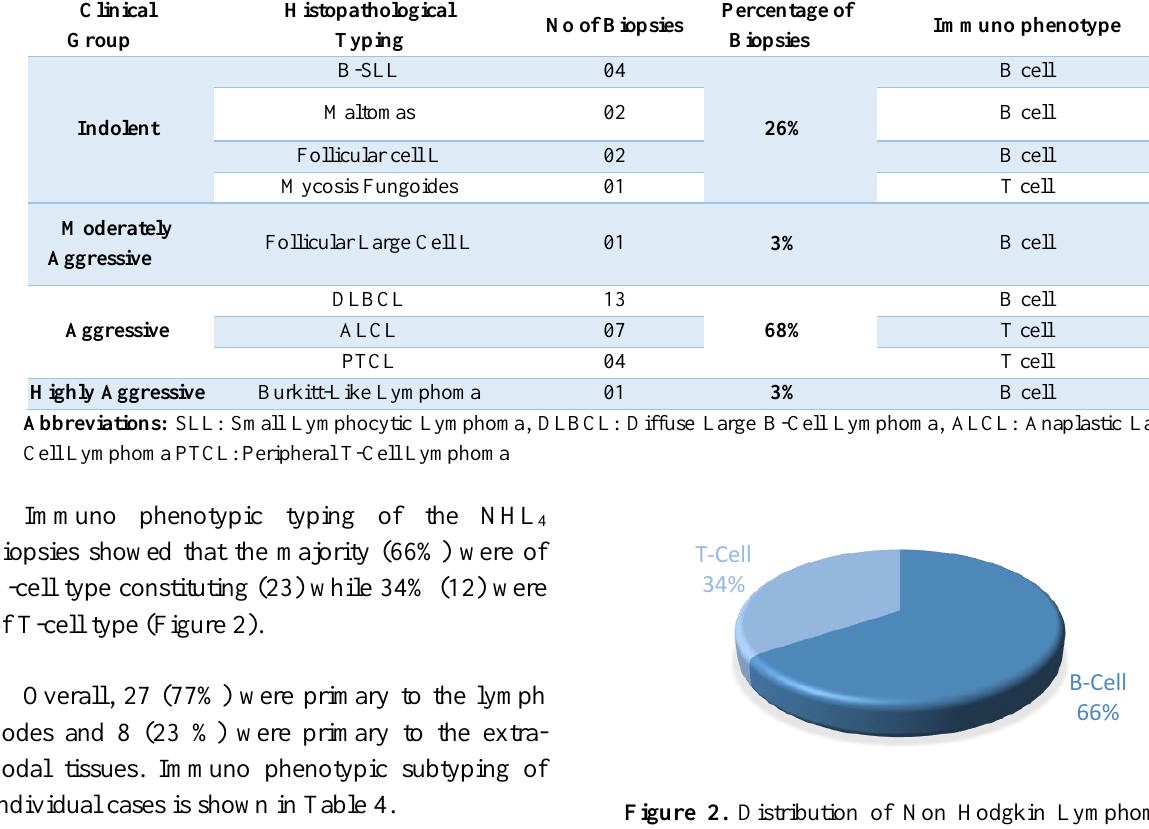
Figure 2. Distribution of Non Hodgkin Lymphomas cases according to